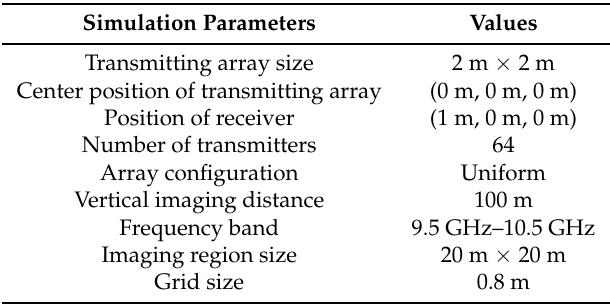
Table 2. Simulation Parameters.